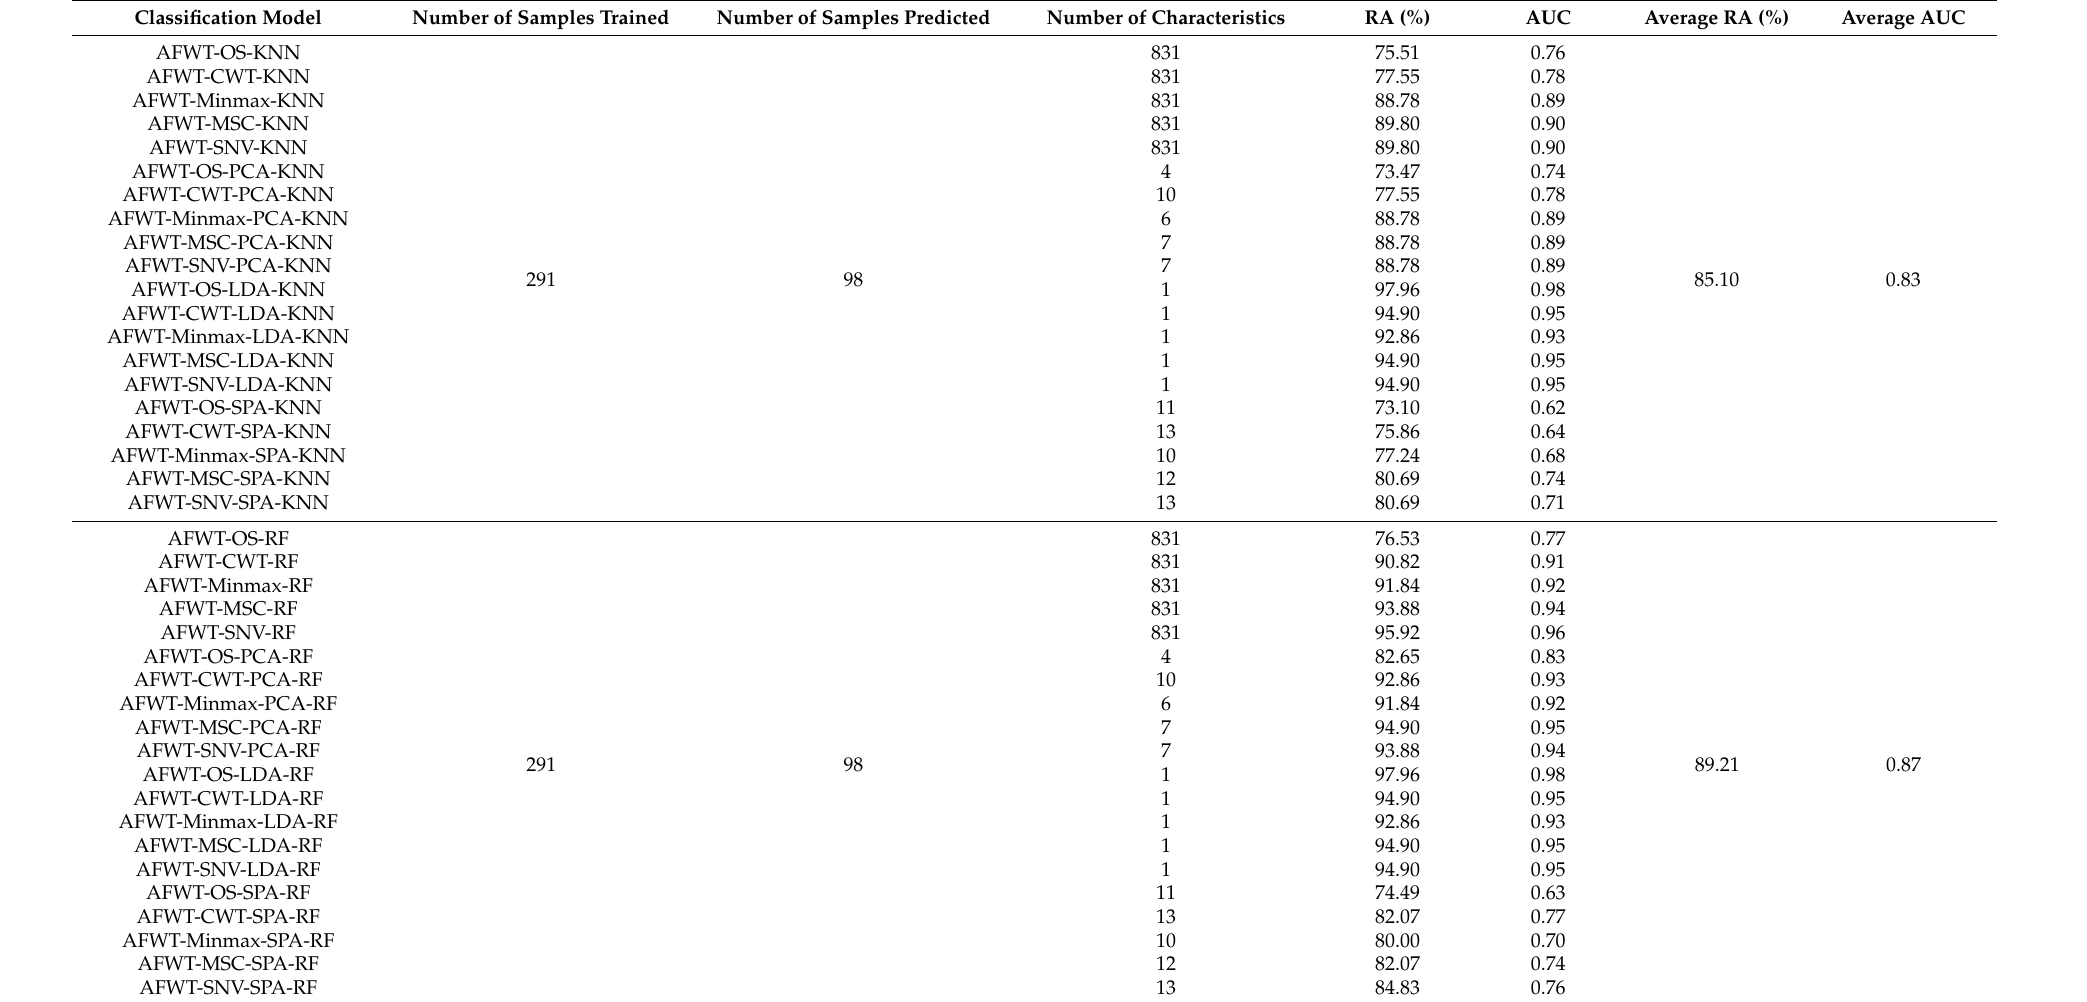
Table 4. Performance Evaluation of Traceability Models of White Tea Classified by